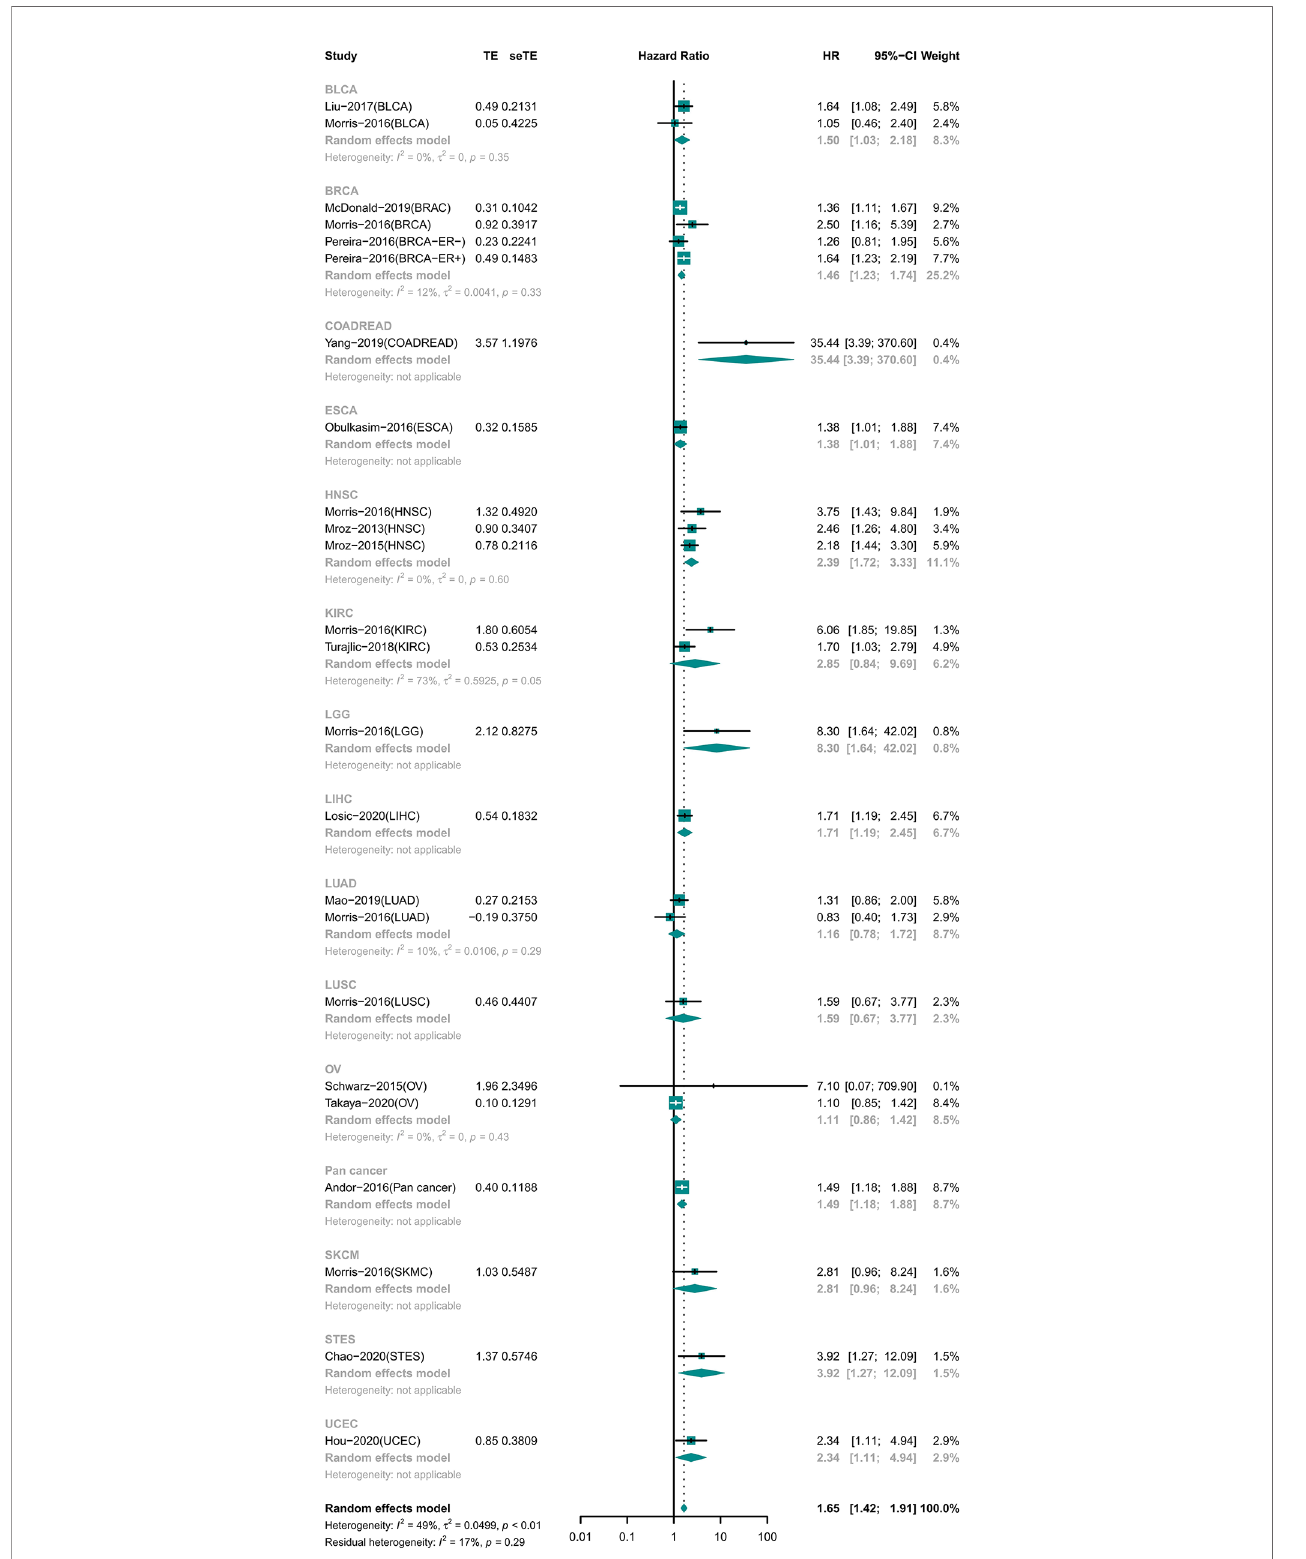
FIGURE 2 | Forest plot of intratumor heterogeneity (ITH) with prognosis in OS.